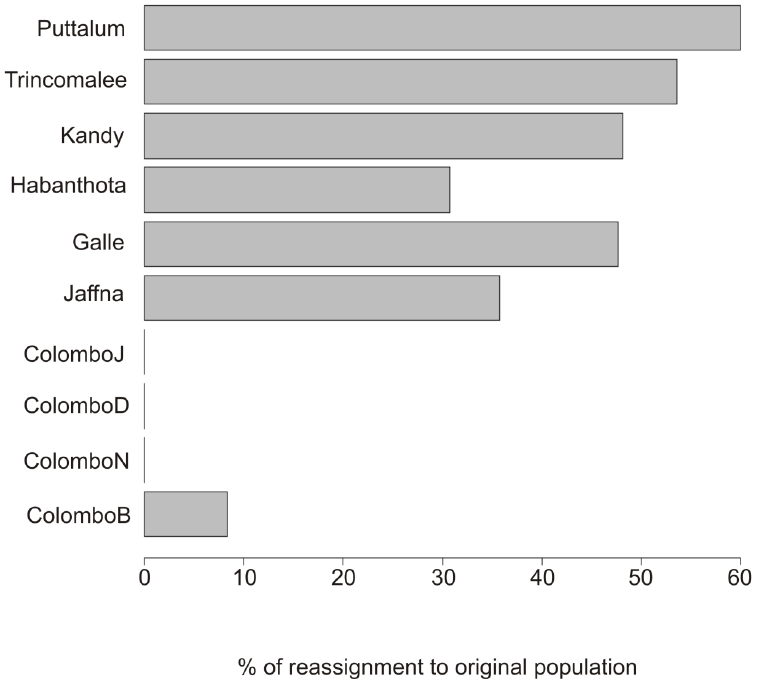
Figure 5. Misclassification of Ae. aegypti individuals in populations from Sri Lanka. Bars indicate the percentage of individuals that are reassigned to their original collection site. Insects 2020 , 11 , x FOR PEER REVIEW The 4NeM values were highly correlated between the two runs (r = 0.753, p < 0.0001), as were values of θ (r = 0.824, p < 0.0034) (Supplementary Figure 3). Mixed gene flow occurred between populations as designated by the arrows in Figure 6, two-headed arrows indicating bi-directional gene flow, one-headed arrows indicating uni-directional gene flow and significant migration rates indicated by black arrows (4Nem > 1) and red arrows (4Nem > 2). All instances where 4Nem < 1, i.e., where sufficient migration between the donor and the recipient populations is not implied to offset genetic drift, is indicated by the absence of arrows (e.g., between Kandy and Trincomalee and between Hambanthota and Trincomalee).